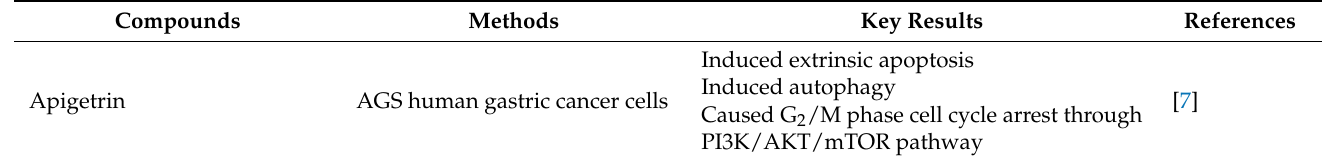
Table 1. Effects of natural compounds in mTOR signaling pathway in